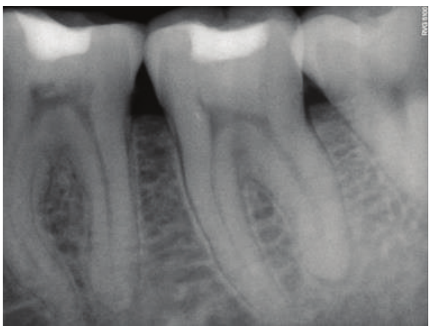
Figure 19: 3-month followup RVG: 36, 37.